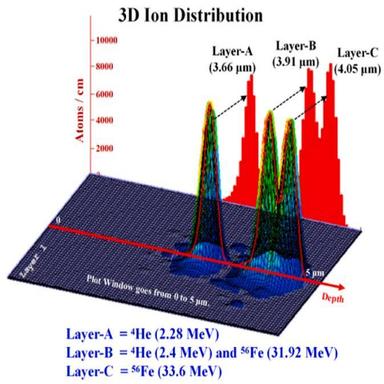
3D ion distribution of 4 He and 56Fe ions in the experimental material under the mono-nuclear energy of 0.57 and 0.60 MeV/u.